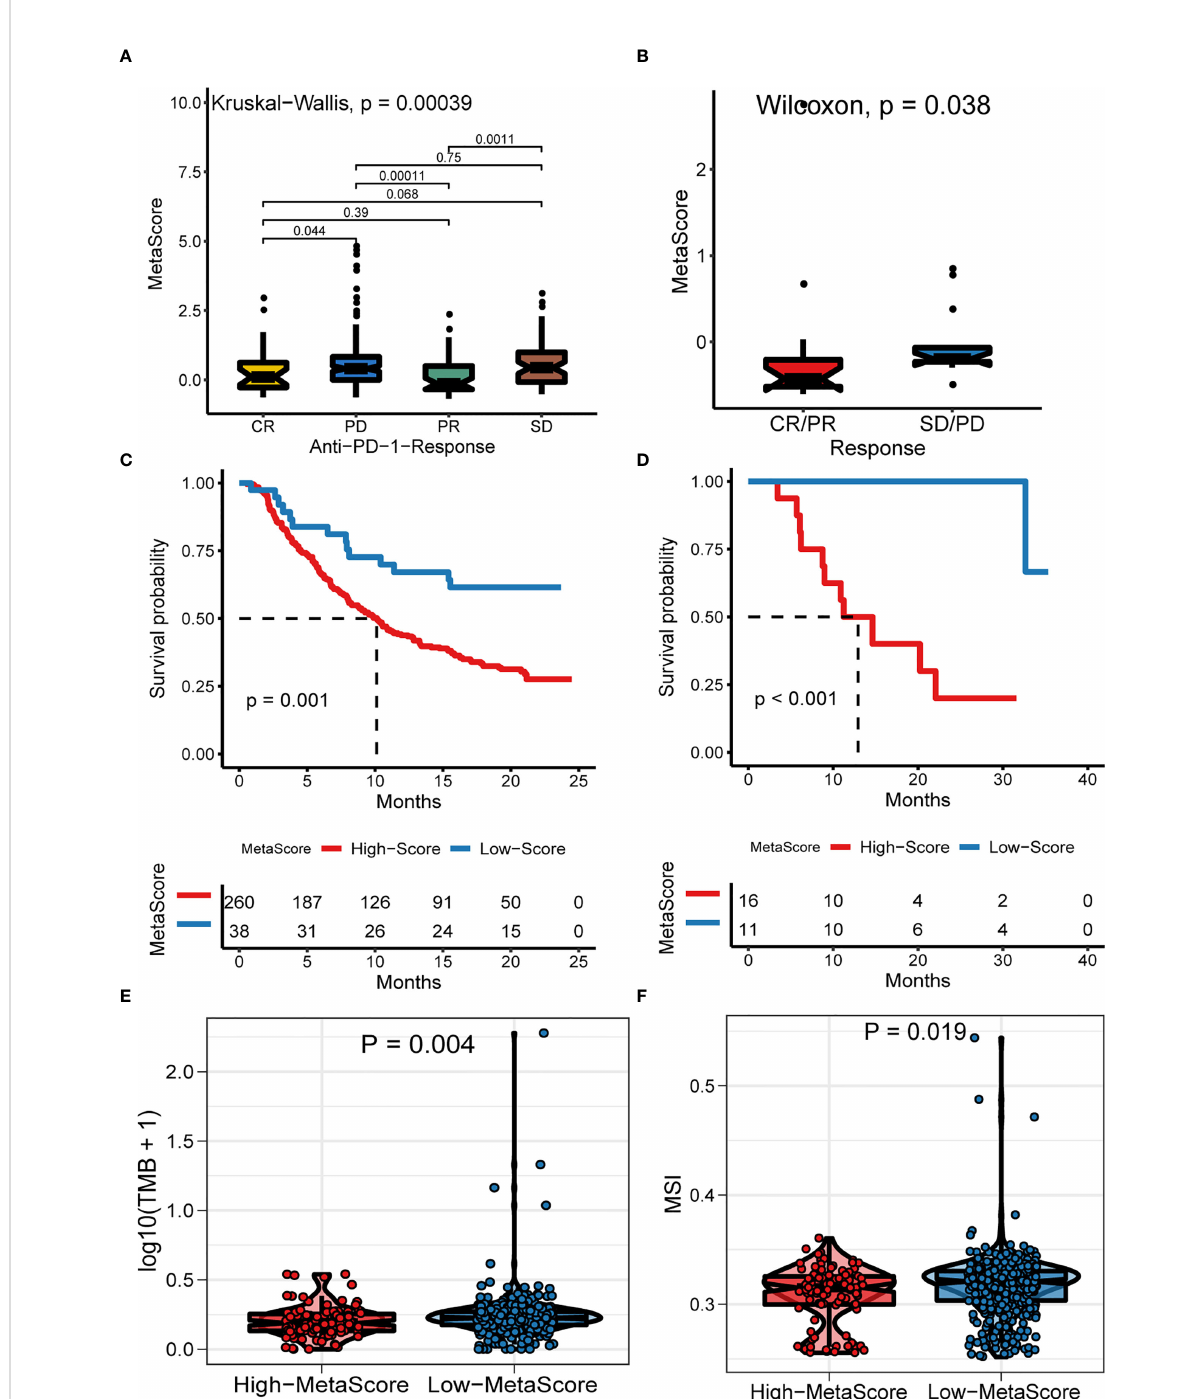
FIGURE 6 The Role of MetaScore in the prediction of immunotherapeutic bene fi ts. MetaScore in groups with a different anti-PD-1 clinical response status (complete response [CR]/partial response [PR] and stable disease [SD]/progressive disease [PD]) in the IMvigor210 cohort (A) and GSE78220 cohort (B) . Kaplan-Meier curves for patients with high- and low-MetaScore in the IMvigor210 cohort (C) and GSE78220 cohort (D) . (E) The differences of TMB between MetaScore groups in the training set. (F) The differences of MSI between MetaScore groups in the training set. TMB, tumor mutation burden; MSI, microsatellite